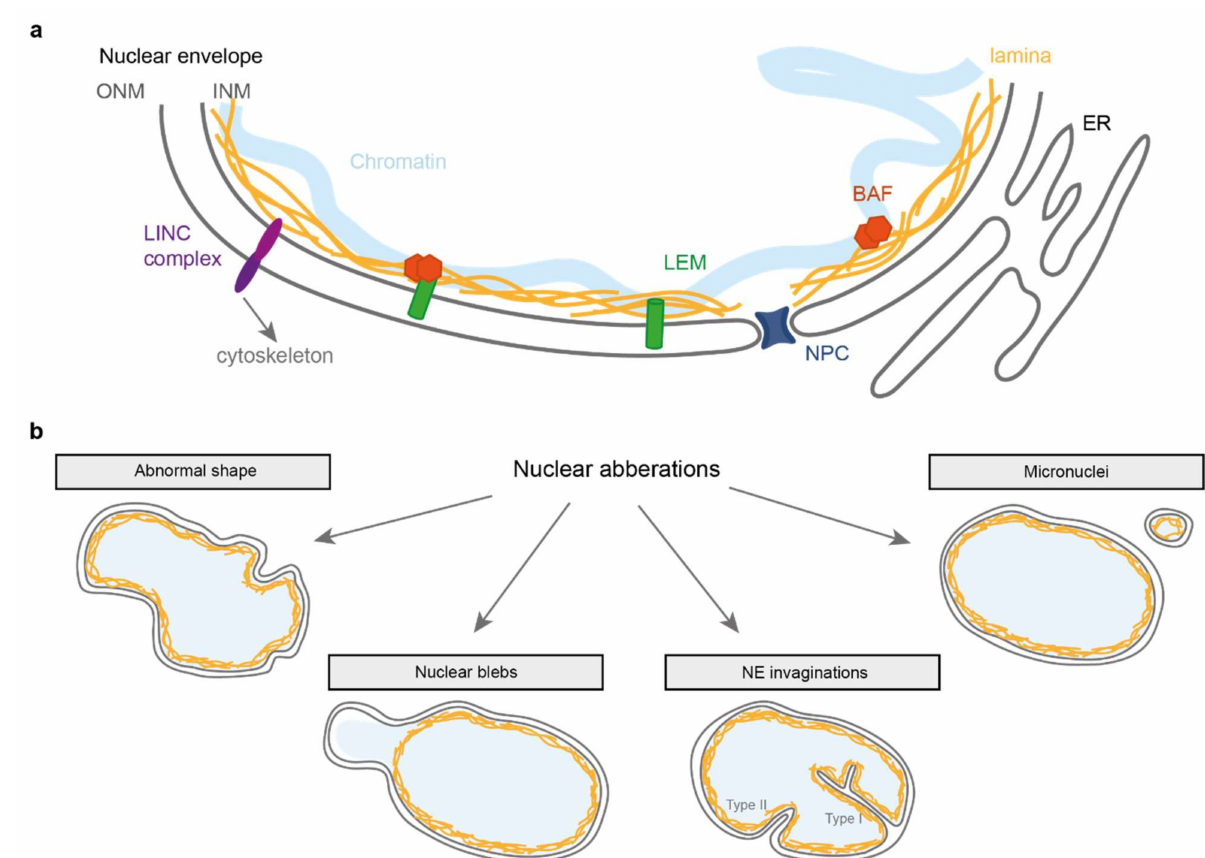
Figure 1. Simplified representation of the nuclear envelope and associated abnormalities. ( a ) The nuclear envelope consists of two membranes: the inner and outer nuclear membrane (INM and ONM respectively). Underlying the INM is the lamina composed of lamin A, B and C protein filaments that provide structural support to the nucleus. At the INM are members of the LEM domain protein family that can bind to the lamina directly or via BAF, a protein that binds DNA and the lamina. Spanning the NE are LINC complexes that connect the nuclear interior to various cytoskeletal components. ( b ) Schematic overview of nuclear aberrations discussed in this